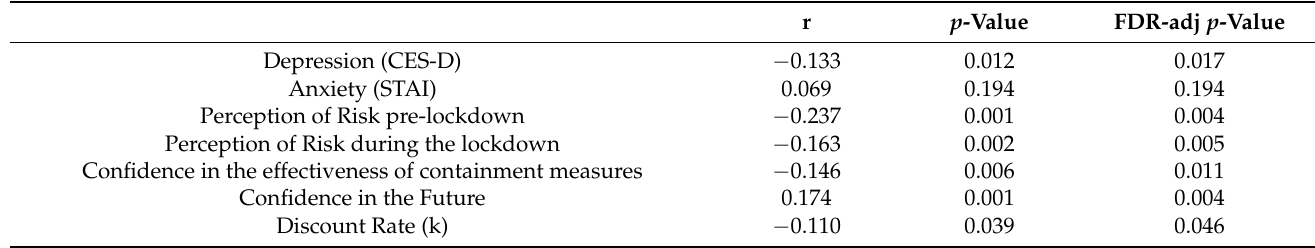
Table 2. Overview of the correlation analyses conducted between the Contagion Risk Index and the other measures of interest.